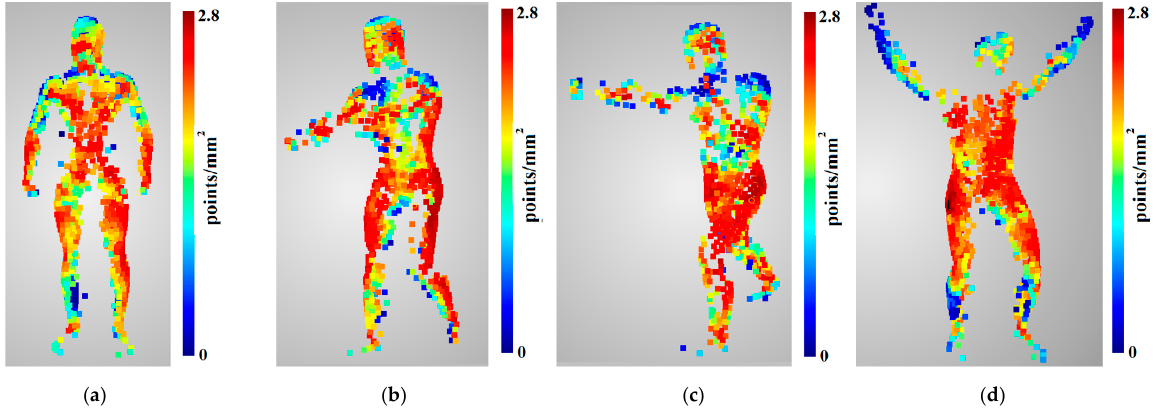
Figure 20. Sparse point clouds of the subject in different poses: ( a ) pose 1, ( b ) pose 2, ( c ) pose 3, ( d ) pose 4, with density evaluations presented as